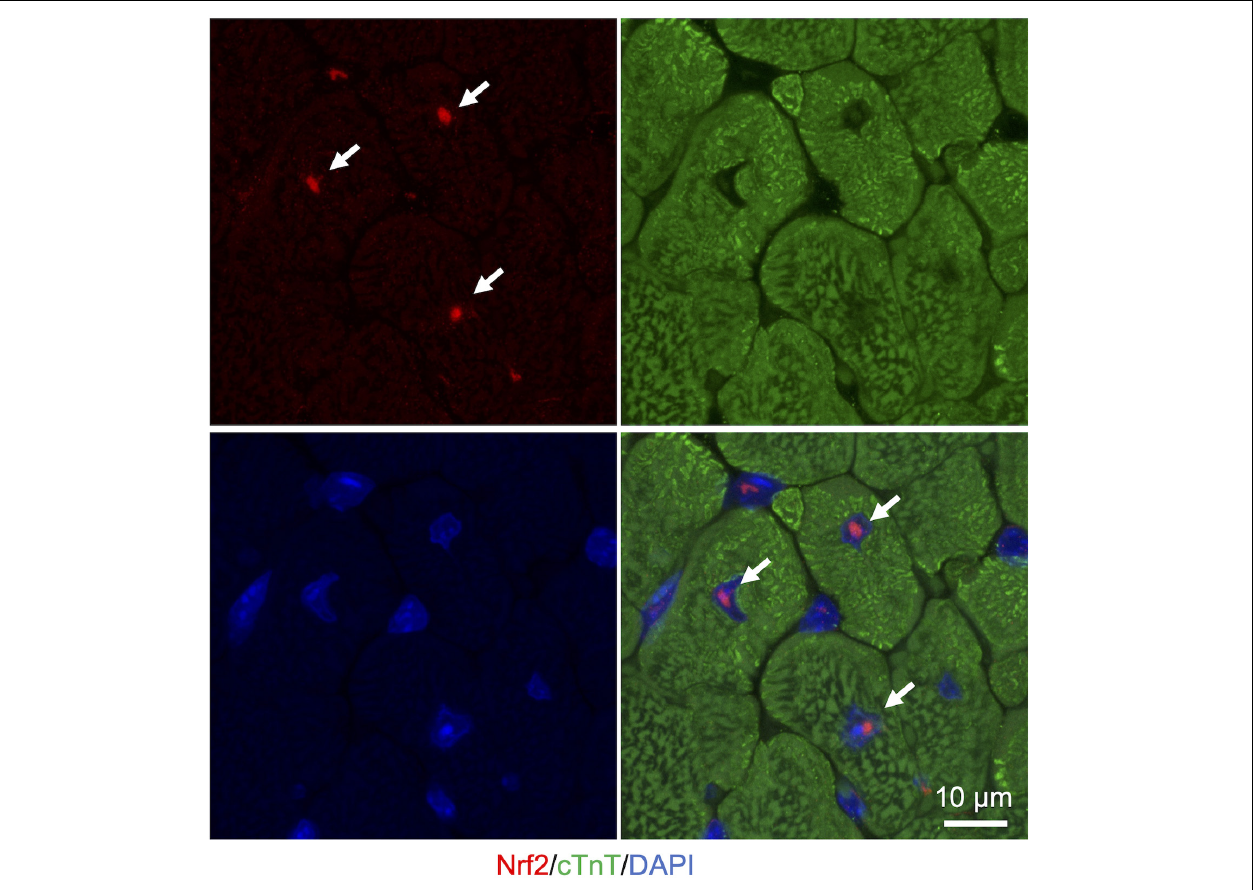
FIGURE 4 | Nuclear Nrf2 condensates in the adult murine heart. Representative images of immunostaining in cryosection of heart from ICR mice (3 months of age). Nrf2 is shown in red. cTnT (cardiac troponin T), a marker for cardiomyocytes, is shown in green. Nuclei are visualized in blue with DAPI. White arrows indicate nuclear Nrf2 condensates in